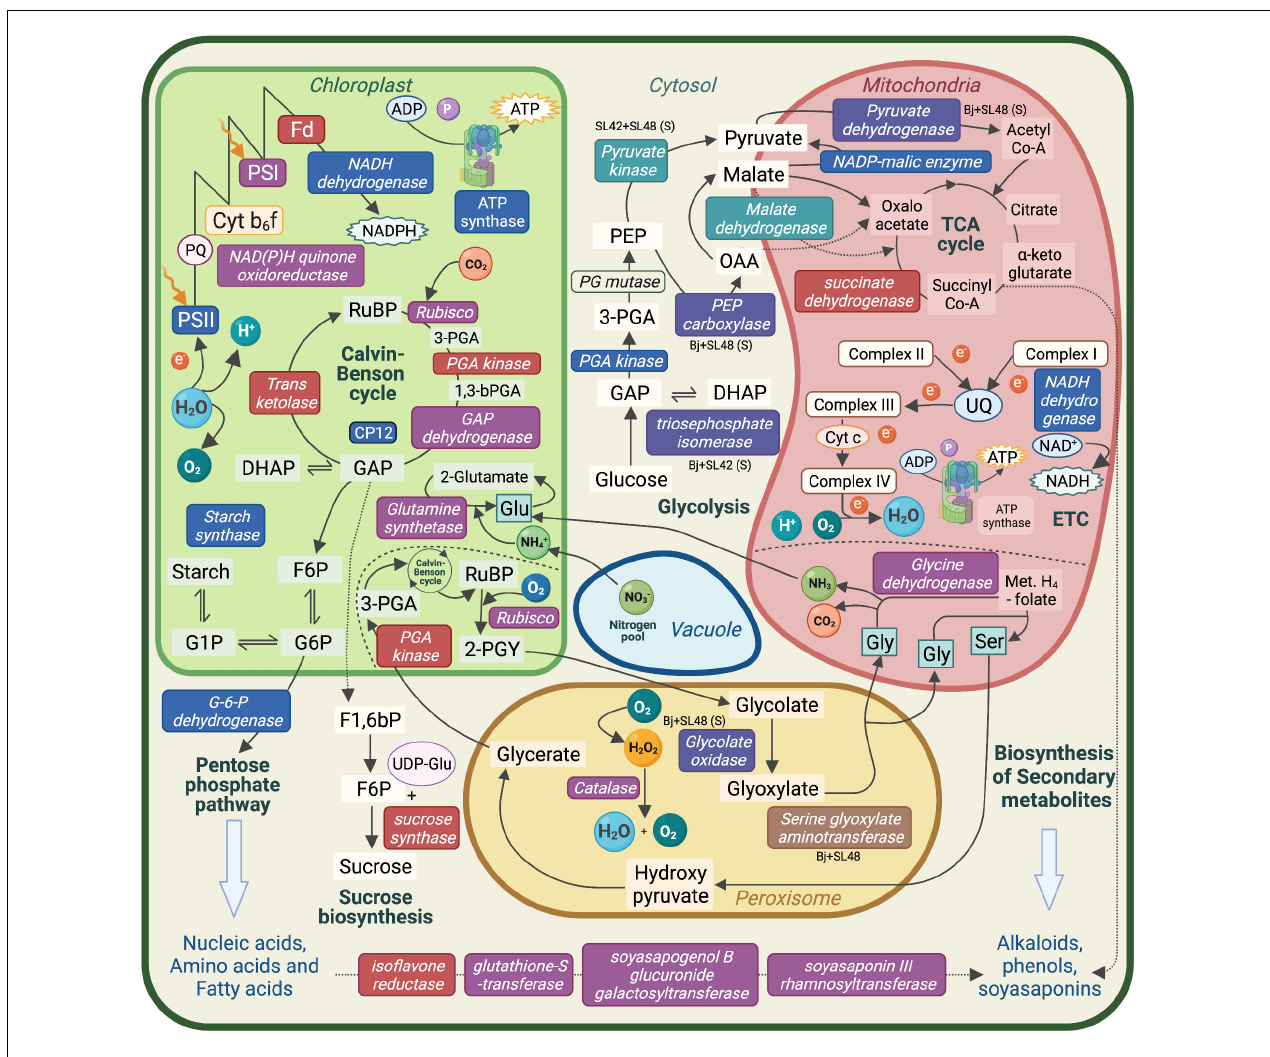
FIGURE 7 | Schematic representation of the major metabolic pathways in a plant cell. Enzymes and molecules involved in photosynthesis, respiration, photorespiration, nutrient assimilation, and biosynthesis pathways that were upregulated in soybean leaf tissue. Upregulated enzymes and molecules by the bacterial co-inoculation treatment, Bradyrhizobium japonicum (Bj) + SL42 + SL48 under optimal conditions are indicated in red text box, salt stress conditions are indicated in blue text box, and both conditions are indicated in purple text box. Other specific treatment conditions are indicated as well. PS, Photosystem; Cyt b 6 f, Cytochrome; Fd, Ferredoxin; PQ, Plastoquinone; UQ, Ubiquinone; RuBP, Ribulose bisphosphate; PGA, phosphoglycerate; GAP, Glyceraldehyde-3-phosphate; DHAP, Dihydroxyacetone phosphate; F6P, Fructose-6-phosphate; G6P, Glucose-6-phosphate; PEP, phospho enol pyruvate; OAA, Oxaloacetate; Met. H4-folate, Methylene H4-folate; Gly, Glycine; Glu, Glutamine; Ser,